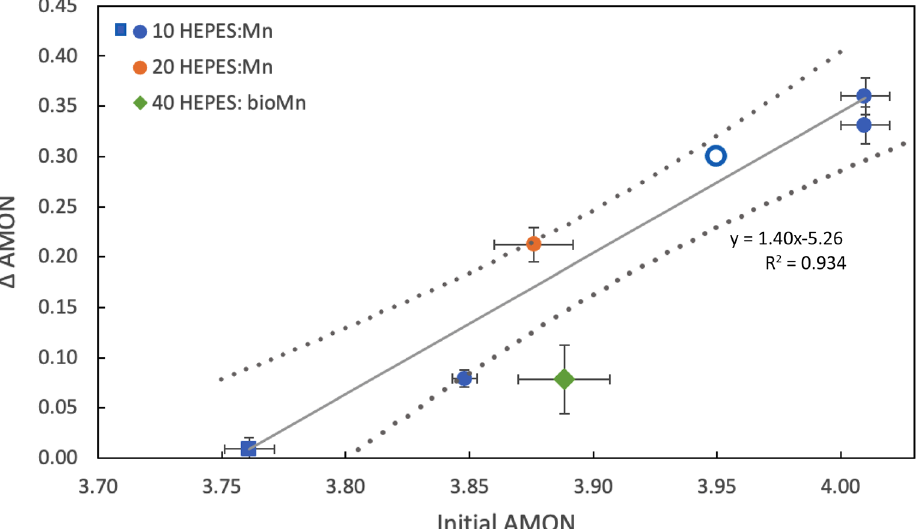
Figure 5. Change in average manganese oxidation number (AMON) as a function of the initial AMON value for abiotic and biogenic Mn oxides. δ-MnO 2 (circles) and c-dis Bi (square) were reacted with HEPES (pH 7.5), while biogenic Mn oxides were reacted at pH 6.8. Open marker represents literature values from Simanova et al. 58 ; see Supplementary Table S5 for a summary of sample information. Horizontal error bars represent the standard deviation between triplicate samples (except for c-disordered birnessite, which was run in duplicate) with vertical error bars calculated following the simple rule for sums and differences and the overlay (grey dotted line) shows the 95% confidence